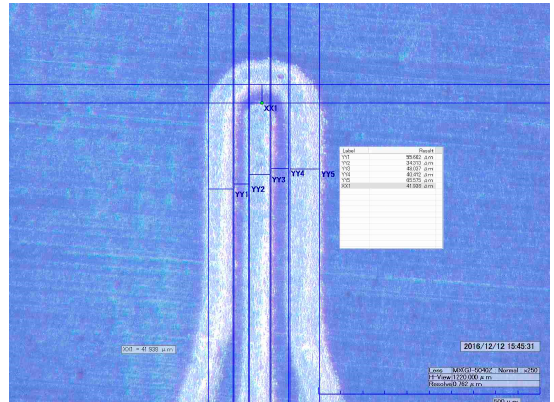
Figure 4. Aerosol printed high-resistance part of the microheater. Heater material is platinum ink (particle size of 3–8 nm), line width is ~50 μ m